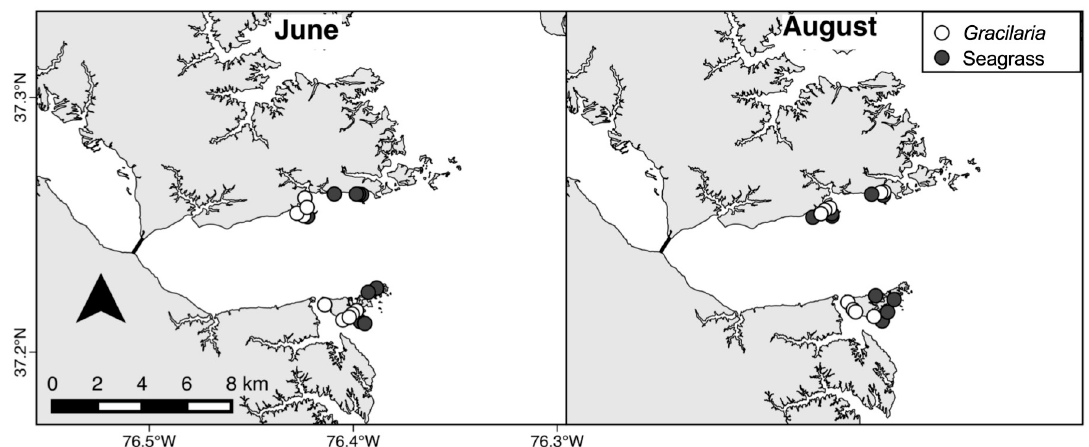
Fig 2. Map of crab sampling locations in June and August in the downriver area of the York